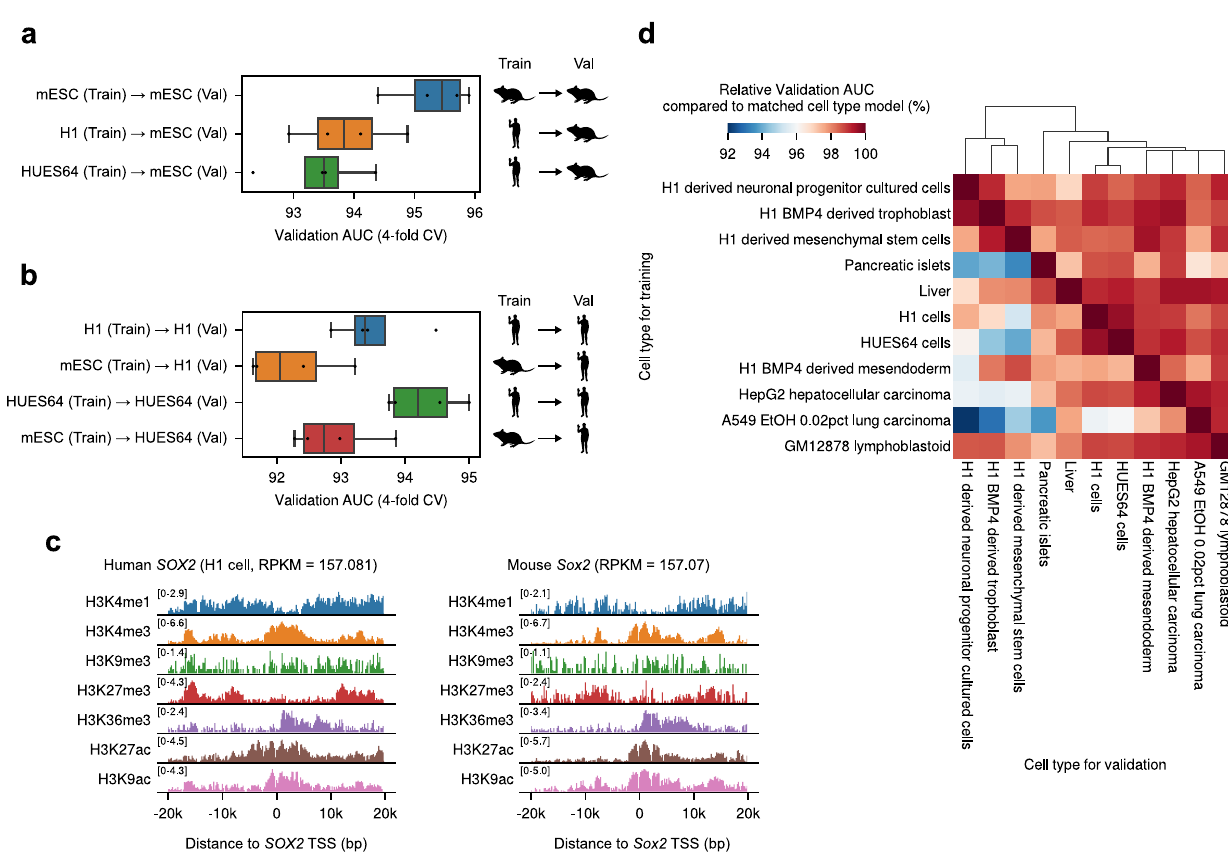
lower box limits denote upper and lower quartiles, and whiskers denote 1.5× interquartile range. c Log2-transformed histone modi fi cation signals surrounding human SOX2 TSSandmouse Sox2 TSS. d Cross-celltypegeneexpressionprediction performances. Colors represent the relative validation AUC compared to the matched cell type Chromoformer-clf model (i.e., trained and evaluated for the same cell type). Val, Validation. Source data are provided as a Source Data fi